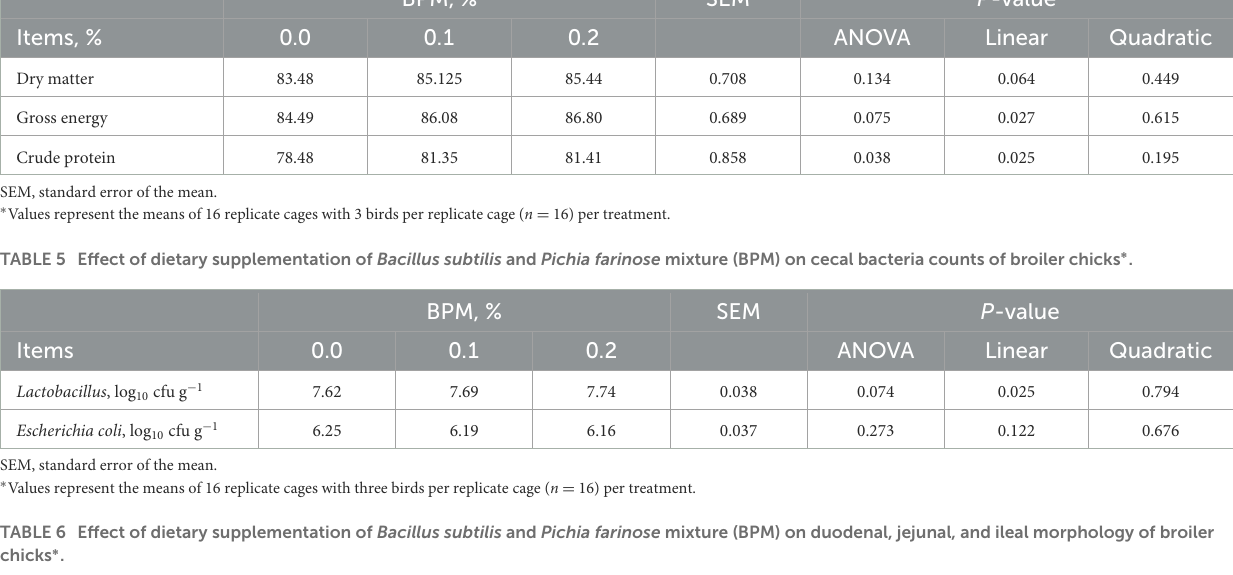
BPM, % SEM P -value